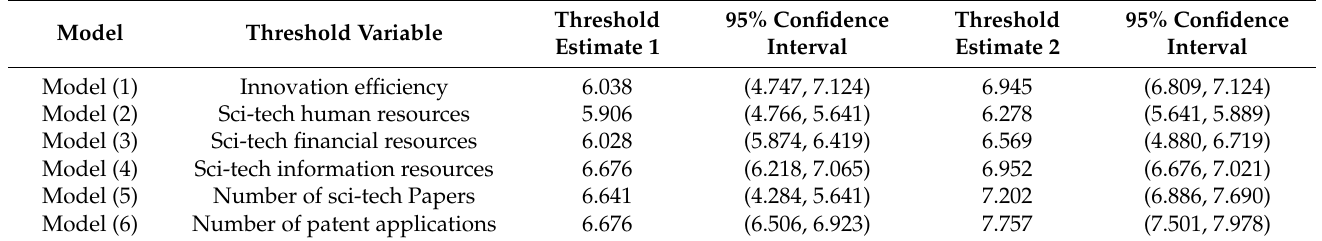
Table 7. Double-threshold Estimates of non-innovative cities.